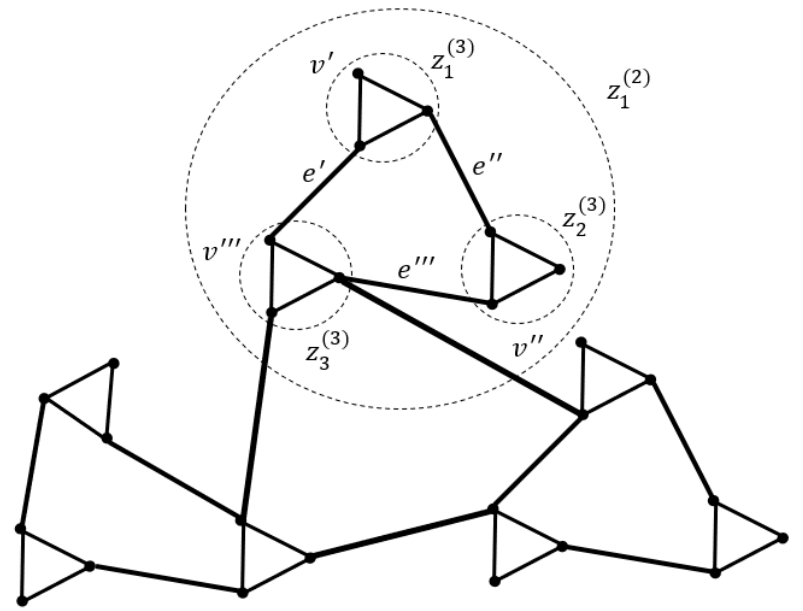
Figure 6. Prefractal graph G 3 the old edges of which are not adjacent.